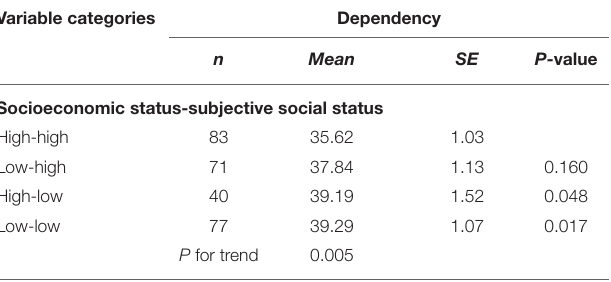
TABLE 4 | The mean and standard error for dependency scores in different groups of SES and SSS by the analysis of covariance. Variable